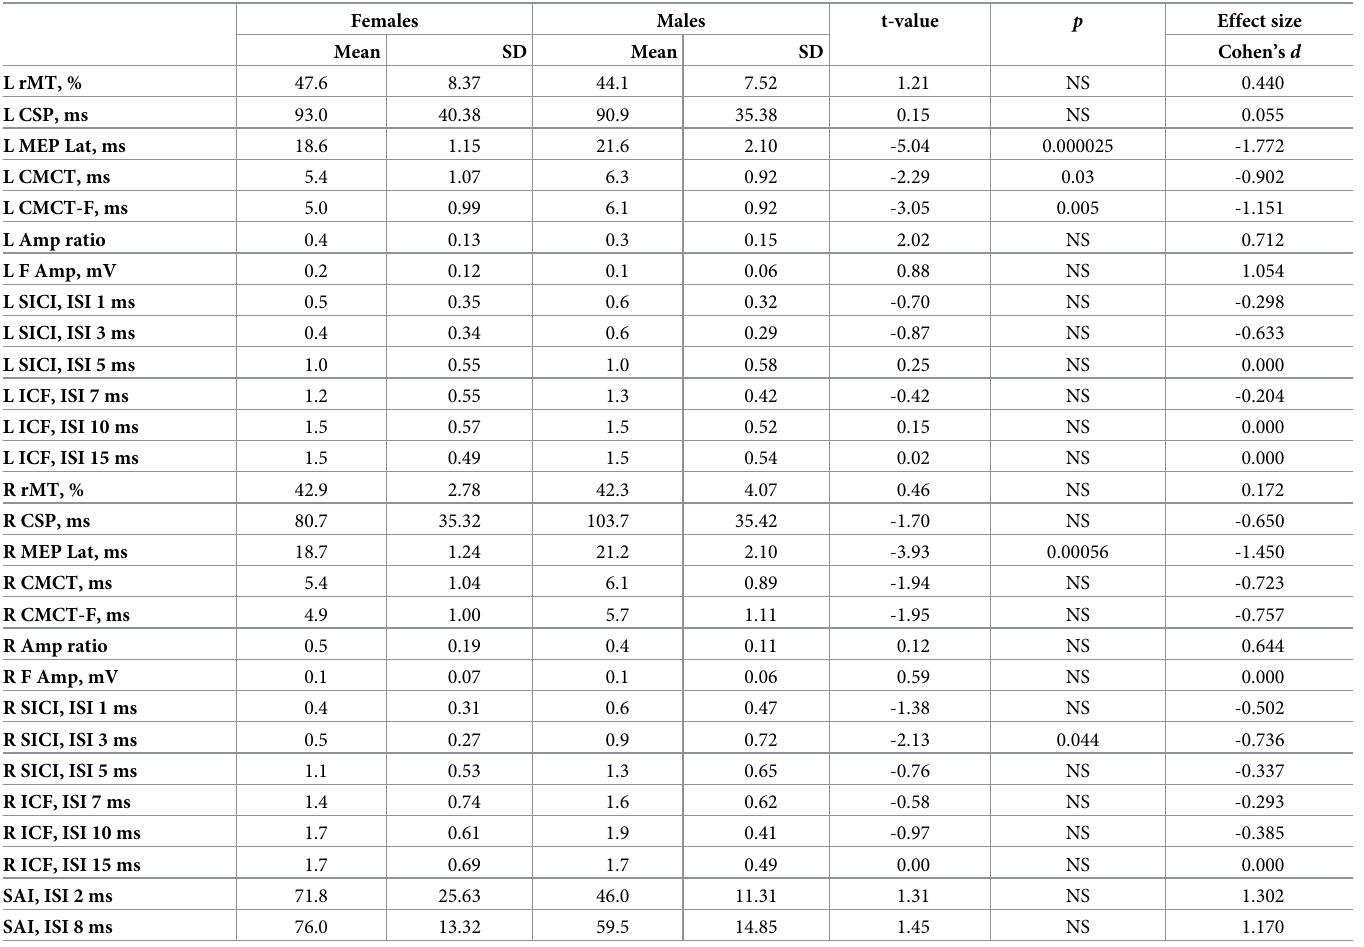
Table 2. TMS measures of male and female participants with mild vascular cognitive